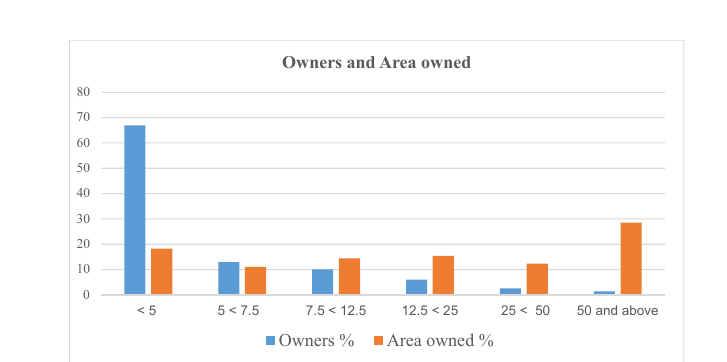
Fig. 1: Distribution of land ownership by farm size in Pakistan, based on data reported in 2010 Census of